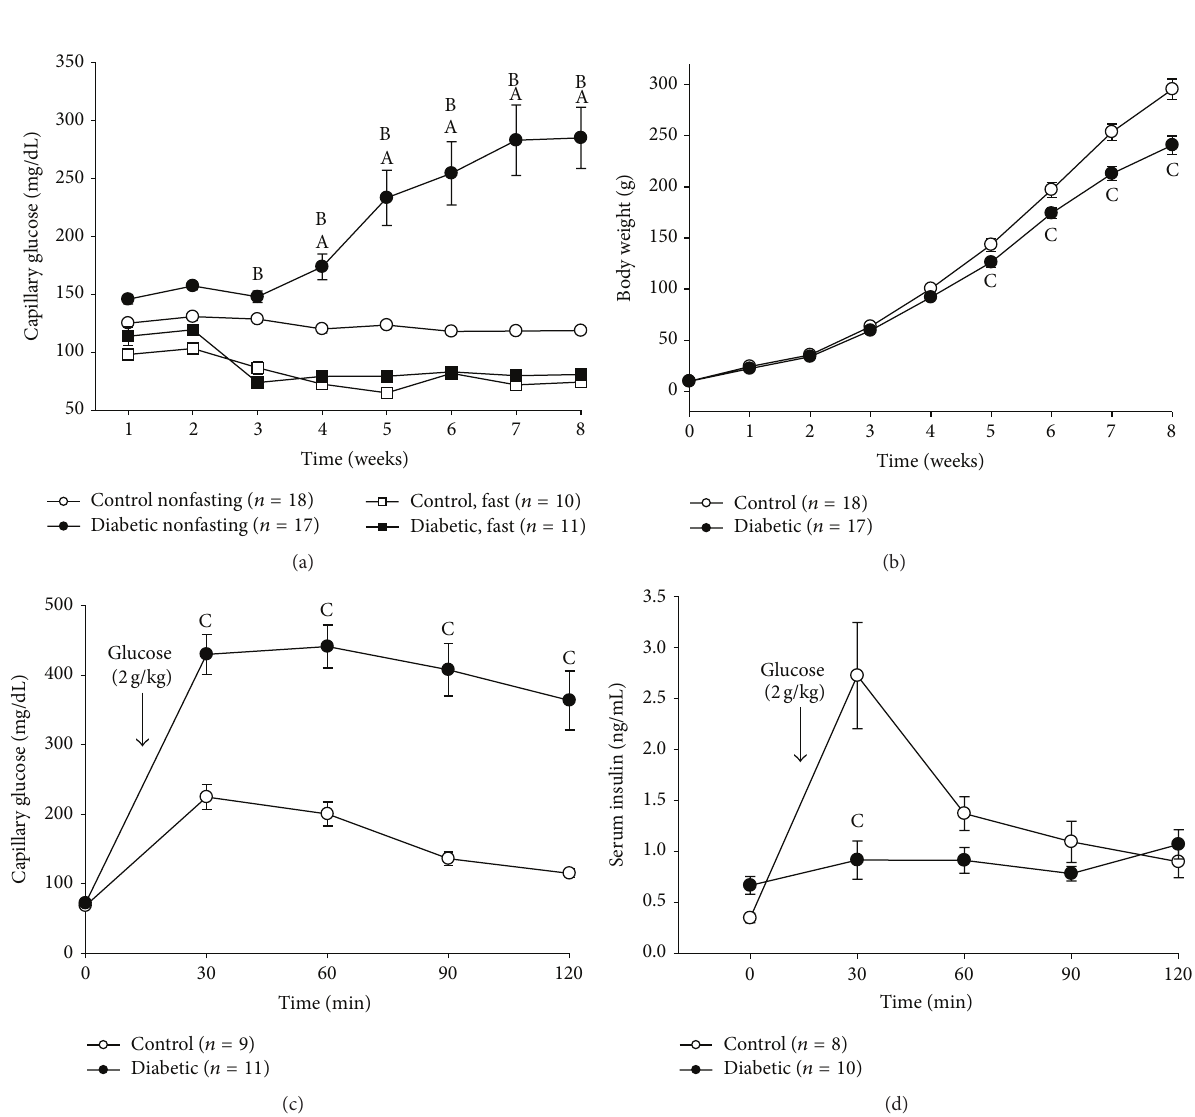
Figure1:Characteristicsofneonatalstreptozotocin-inducedT2Dratmodel.Time-courseof(a)capillaryglucoseconcentrationsand(b)body weight from control- (CT-) and diabetic- (DB-) rats. (c) Capillary glucose levels and (d) serum insulin concentrations before and during an oral glucose tolerance test (OGTT) (2g/Kg) in 8-week-old CT- and DB-rats. A 𝑃 < 0.05 versus CT nonfasting, B 𝑃 < 0.05 versus DB fast, and C 𝑃 < 0.05 versus control two-way ANOVA followed by Duncan’s post hoc